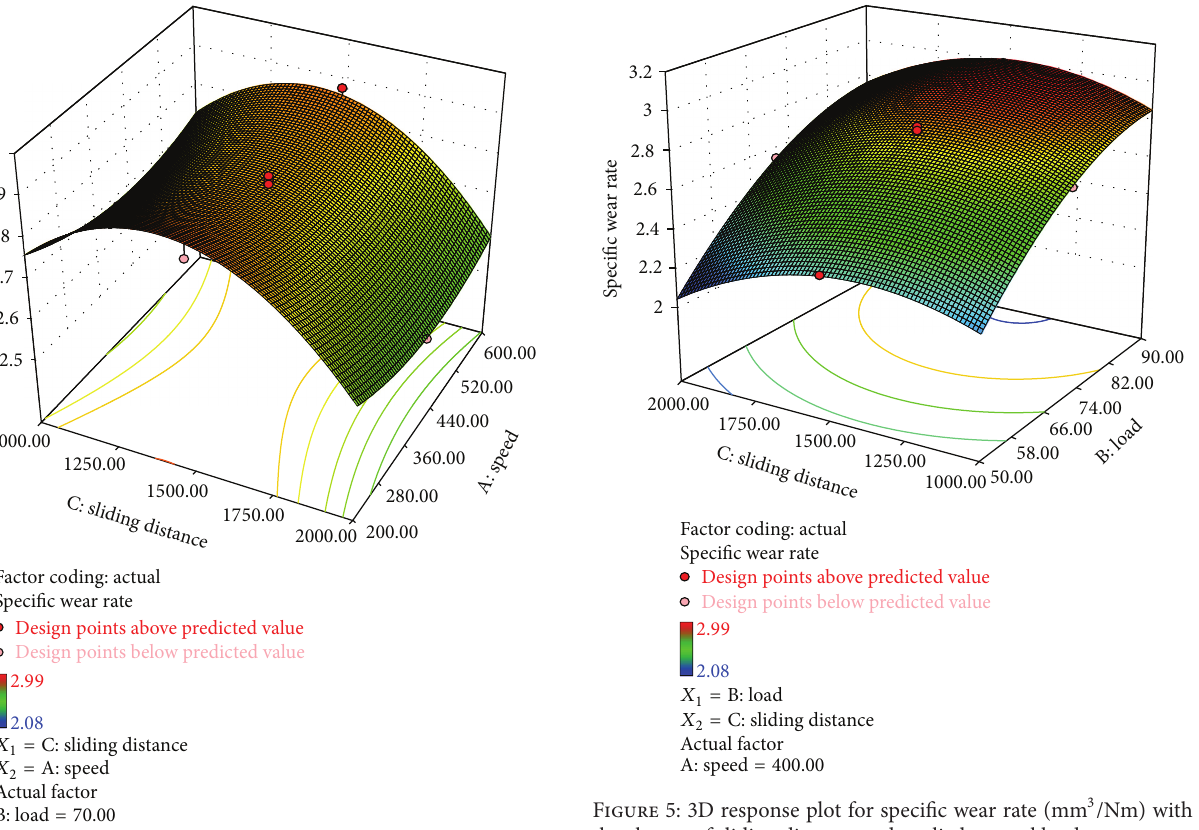
Figure 4: The 3D response plot for specific wear rate (mm 3 /Nm) with the change of sliding distance and sliding speed.